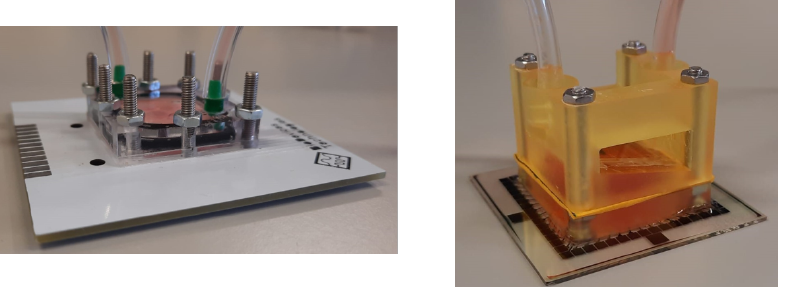
Figure 3. The closed systems evaluated are shown: on the right side, the commercial MEA + 3D printer resin, and on the left, the PCB system.